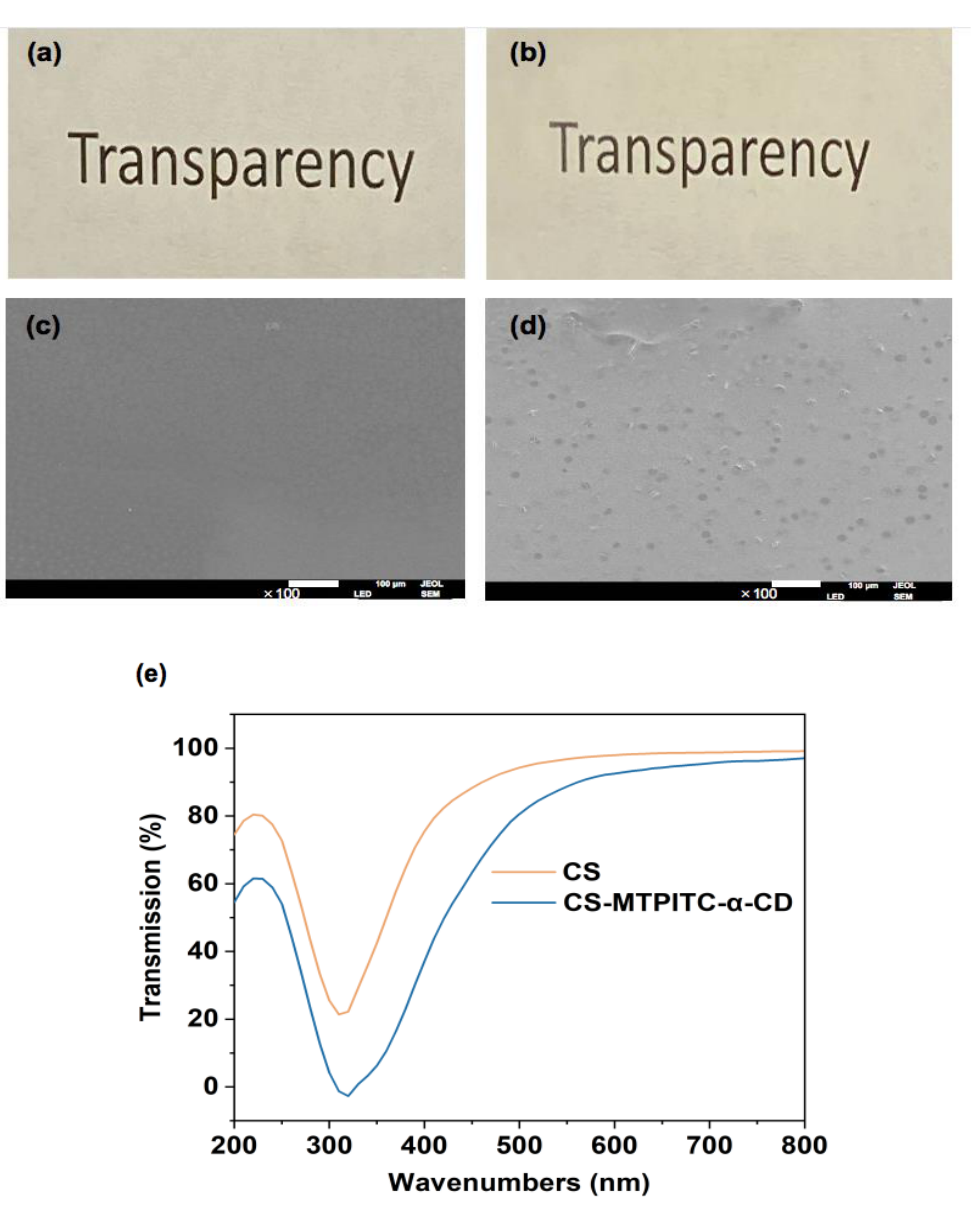
Figure 2. Physical appearance and surface morphology of the CS and CS − MTPITC − α − CD films. Physical appearance of ( a ) CS and ( b ) CS − MTPITC − α − CD films; surface morphology of ( c ) CS and ( d ) CS − MTPITC −α− CD films; ( e ) UV – vis light transmittance of CS and CS − MTPITC −α− CD films.